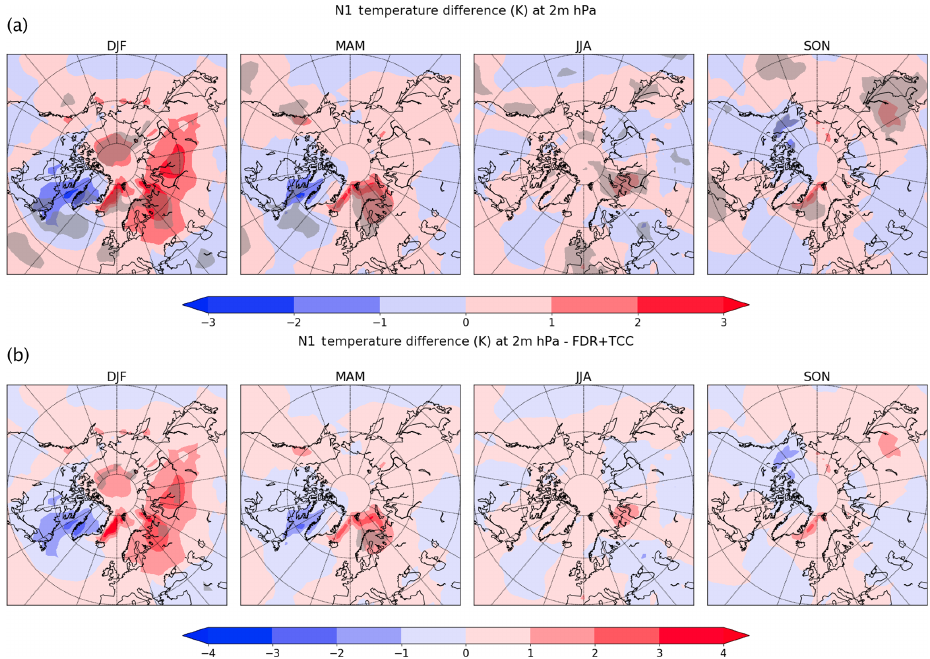
Figure 8. Temperature differences at 2m (high-Ap–low-Ap values) without (a) and with (b) temporal (TCC) and spatial (FDR) autocorrela- tion corrections. The grey areas indicate statistically significant temperature differences at the 5%